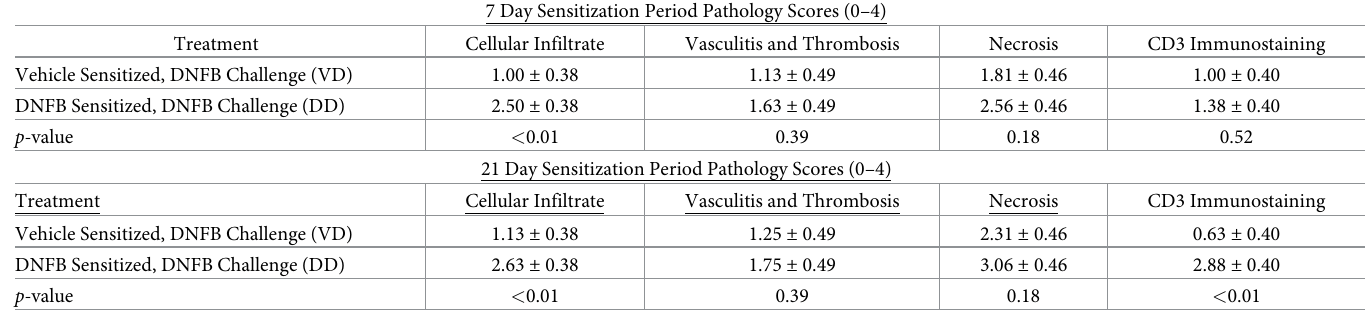
Table 2. Histology and immunohistochemistry scoring of ear sections from VD and DD hapten treated ear biopsy samples (7 and 21 day sensitization periods). Measures of pathology, including cellular infiltrate, vasculitis and thrombosis, and necrosis were scored from H&E preps on a 0–4 scale. In addition, CD3 immunostaining of ear biopsy samples was also performed and scored on a 0–4 scale. Depicted are the Lsmeans and standard errors of 4 ear punches per VD and DD treatment for both the 7 and 21 day sensitization studies and the p -value testing statistical significance of the difference between VD and DD groups within sensitization